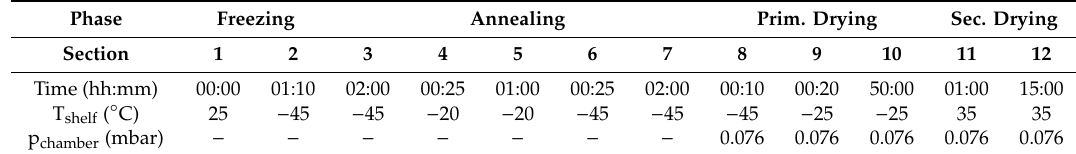
Table 2. Freeze-drying process. Prim. (primary), Sec. (secondary), p chamber (chamber pressure), T shelf (shelf